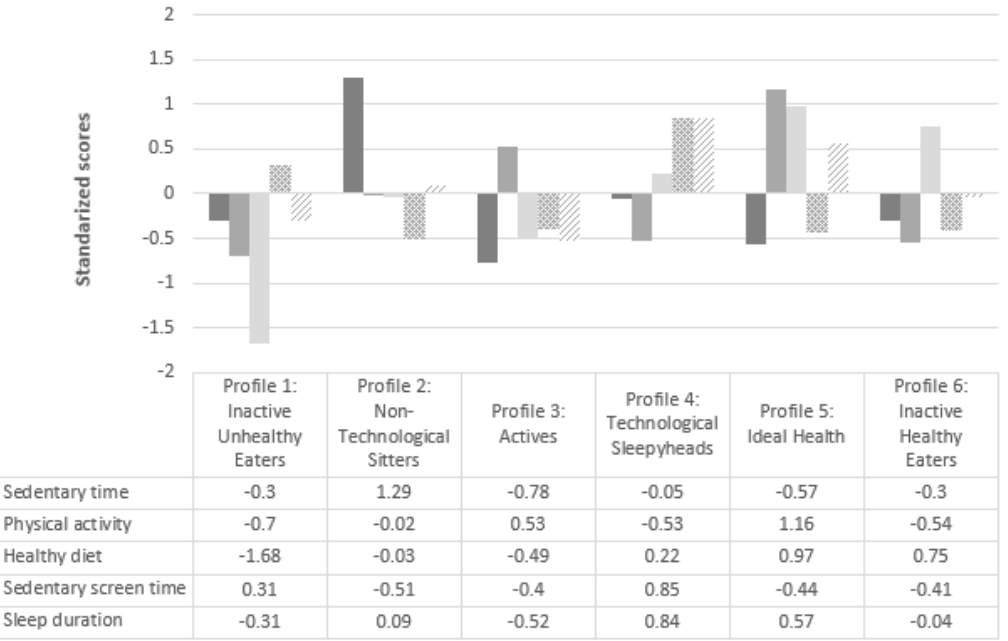
Figure 1. Six-cluster solution based on z-scores for ST, MVPA, healthy diet, sedentary screen time and sleep duration.